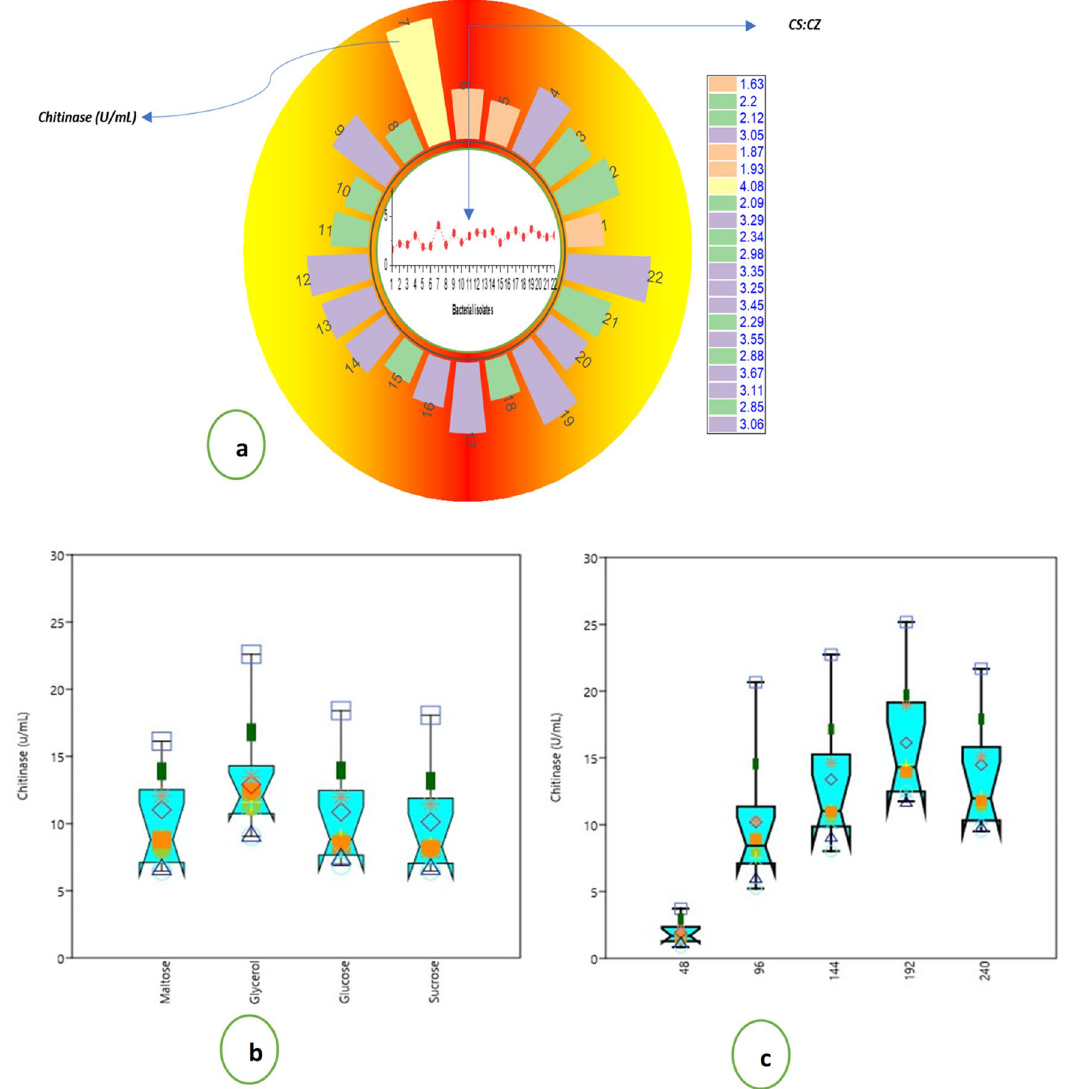
Figure 4. Magnitude of chitinase production among the isolated microflora; ( a ) chitinase activity (U/mL) of the isolated bacterial strains and their respective colony size to clearance zone ratio. ; (b) Variation of chitinase production (U/mL) with sole carbon source viz., maltose, glycerol, glucose and sucrose; ( c ) Incubation period viz., 48, 96, 144, 192, and 240